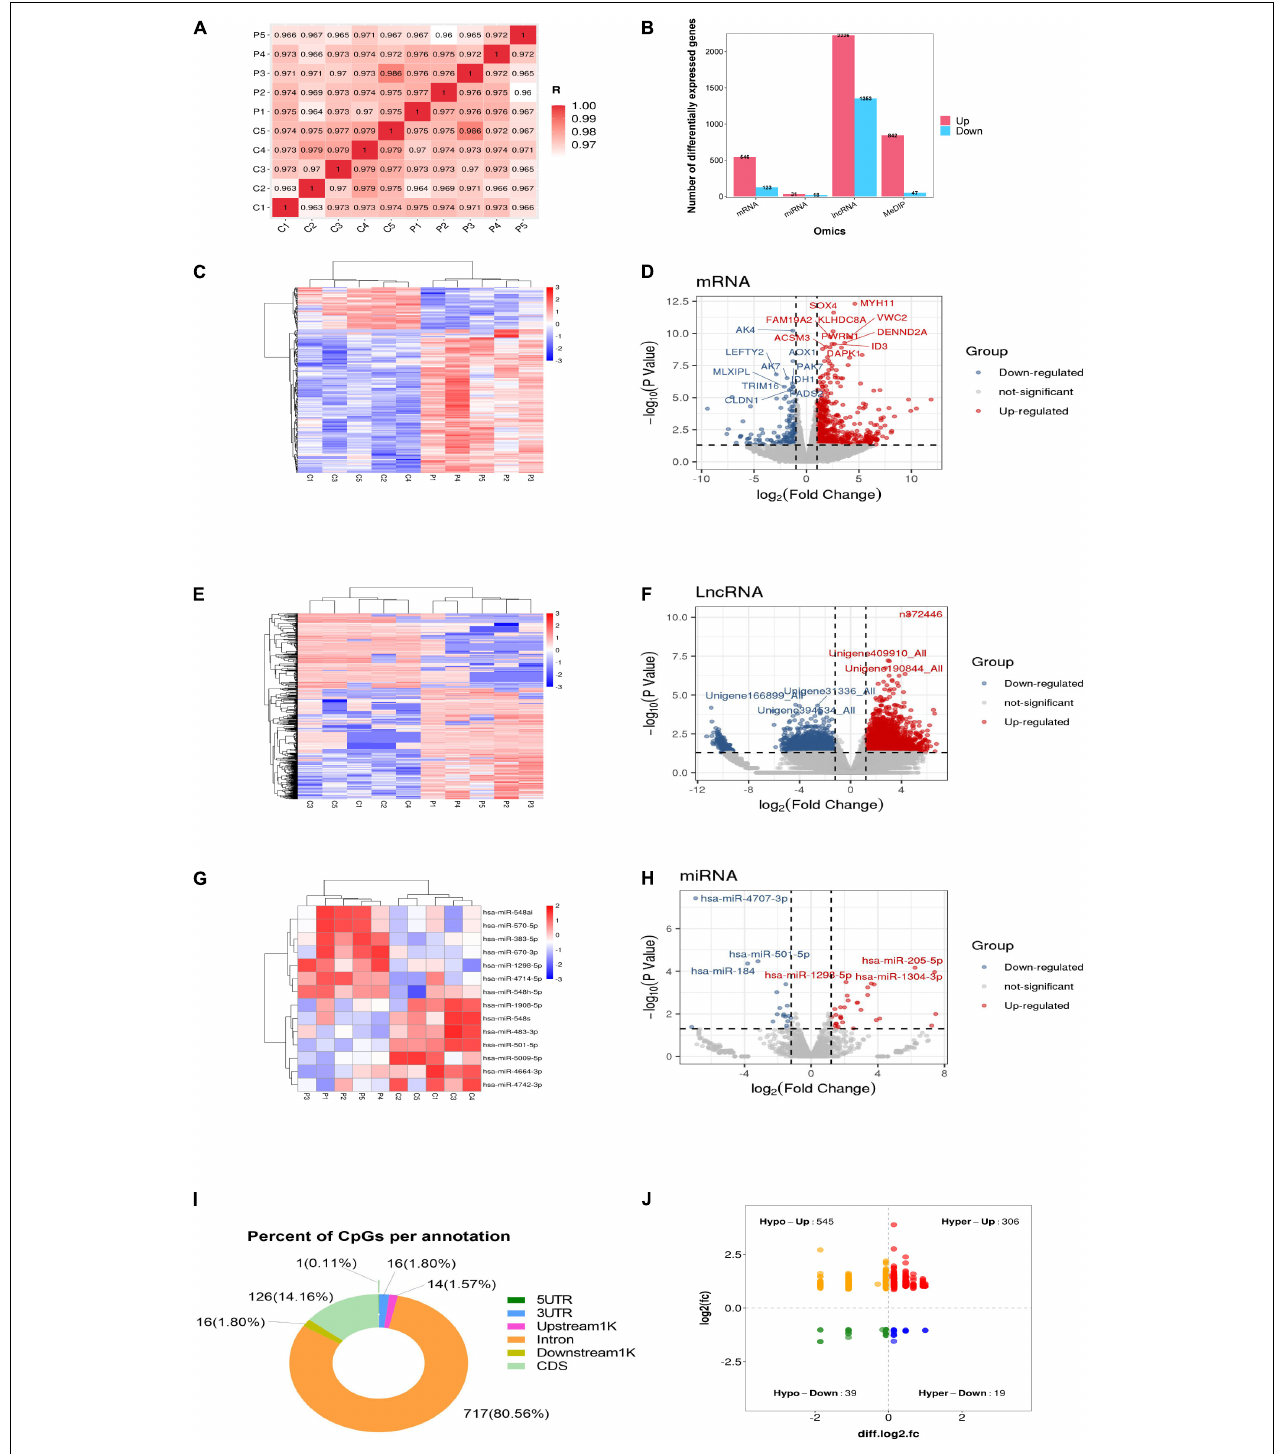
FIGURE 1 | Global differentially expressed mRNAs, lncRNAs, miRNAs, and differentially methylated regions (DMRs) identified in PCOS and control granulosa cells. (A) Correlation heatmap between PCOS and control samples. (B) The numbers of differentially expressed mRNAs, differentially expressed lncRNAs (DELs) and differentially expressed miRNAs (DEMs). (C) Hierarchical clustering presentation of DEGs in the PCOS and control groups. (D) Volcano plot of DEGs in the PCOS and control groups. (E) Hierarchical clustering presentation of DELs in the PCOS and control groups. (F) Volcano plot of DELs in the PCOS and control groups. (G) Hierarchical clustering presentation of DEMs in the PCOS and control groups. (H) Volcano plot of DEMs in the PCOS and control groups. (I) The distribution of DMRs. (J) The correlation of DMR-associated genes and mRNA expression.